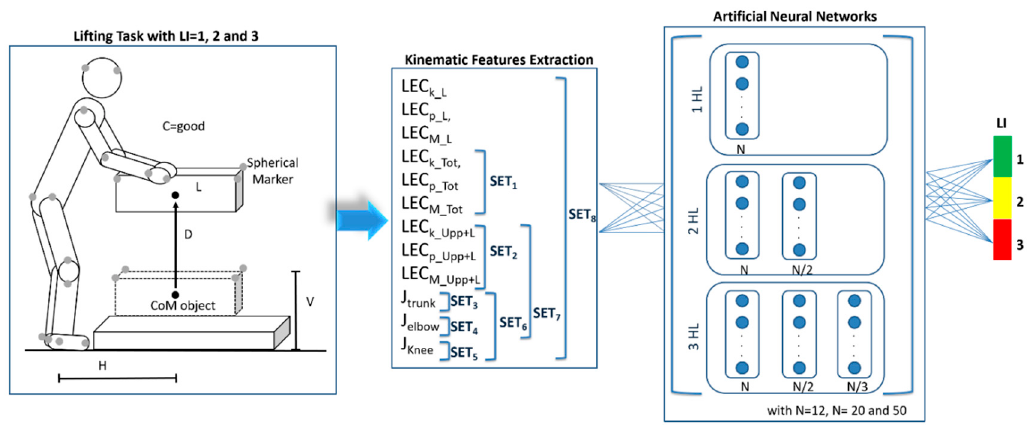
Figure 1. Schematic diagram of the study. The three boxes of the flowchart represent the lifting task, the feature extraction from recorded data, and the ANN architecture to map kinetic features on the Lifting Index (1, 2, and 3) levels. L: load weight; H: horizontal location; V: vertical location; D: